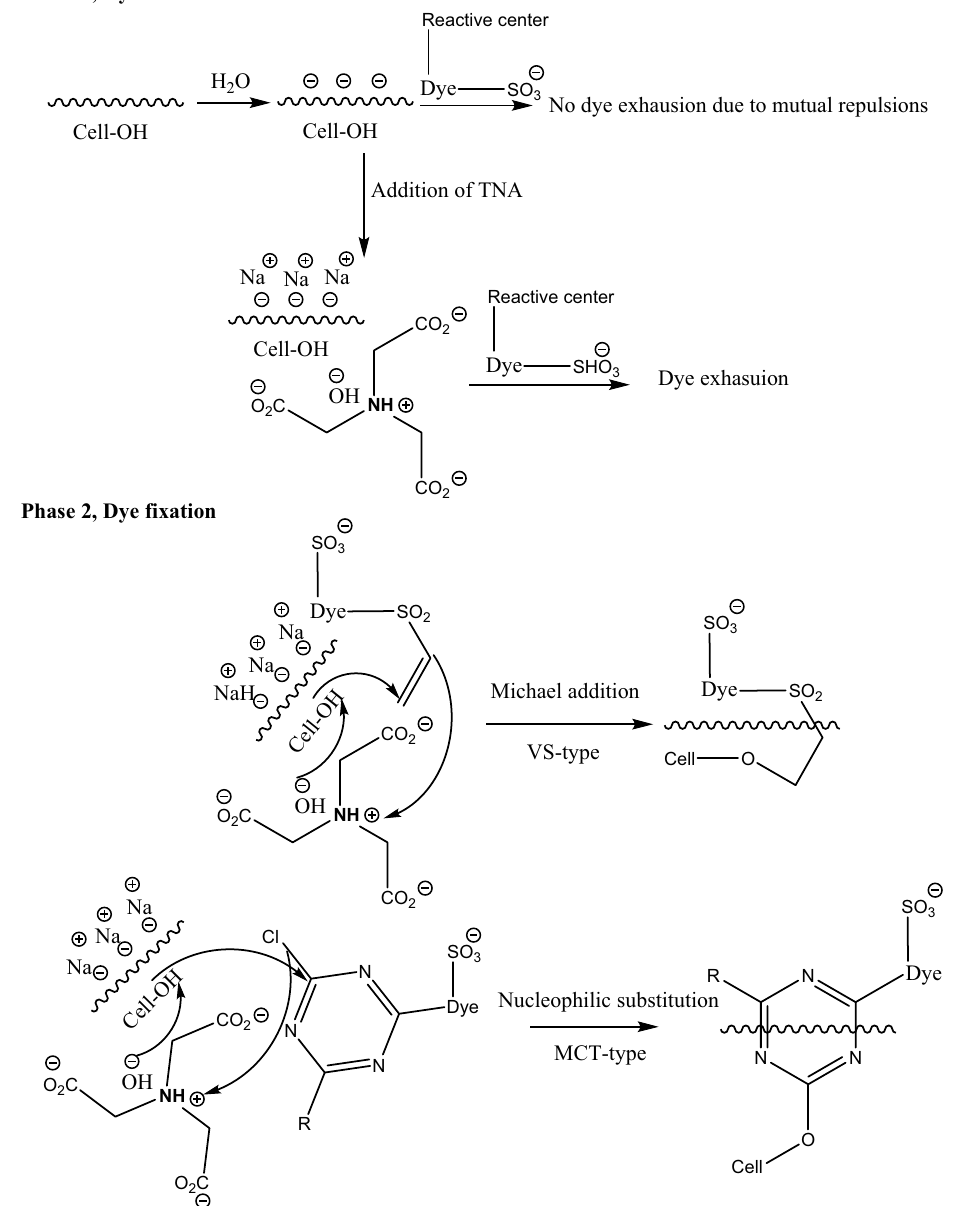
Figure 13. Dyeing mechanism of reactive dyes on cotton fabrics using TNA.